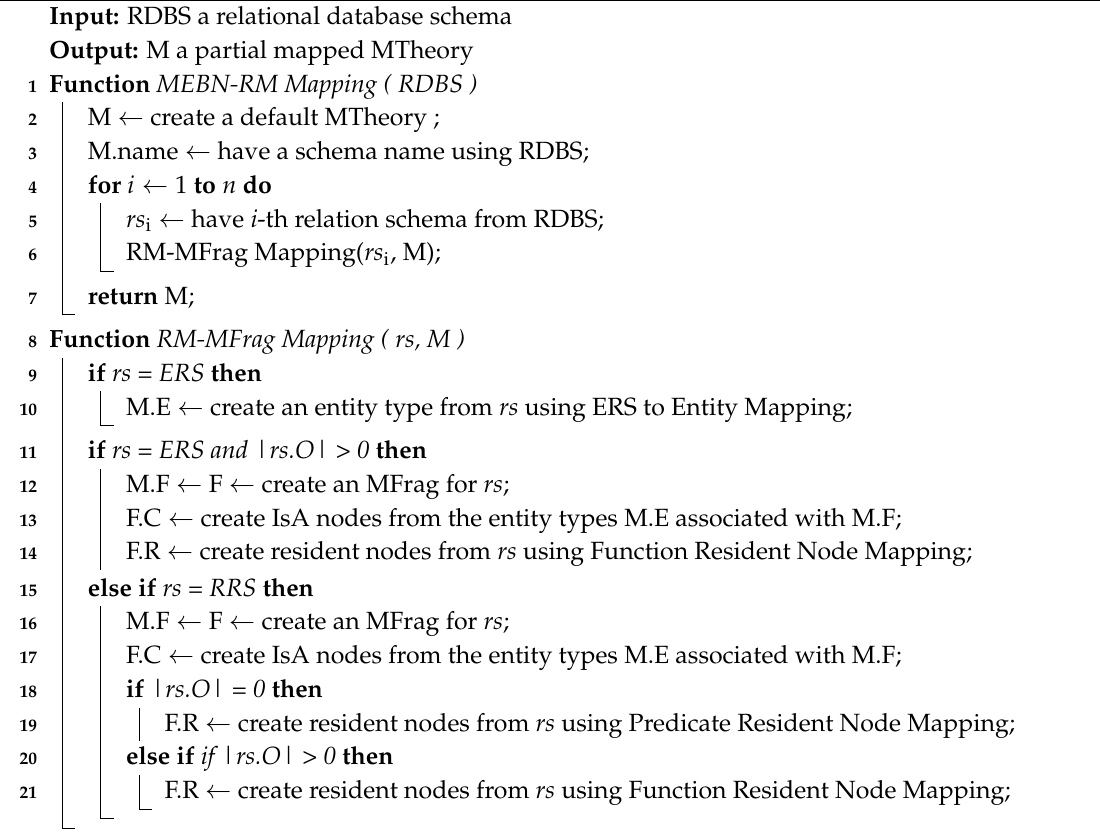
Algorithm 1: MEBN-RM